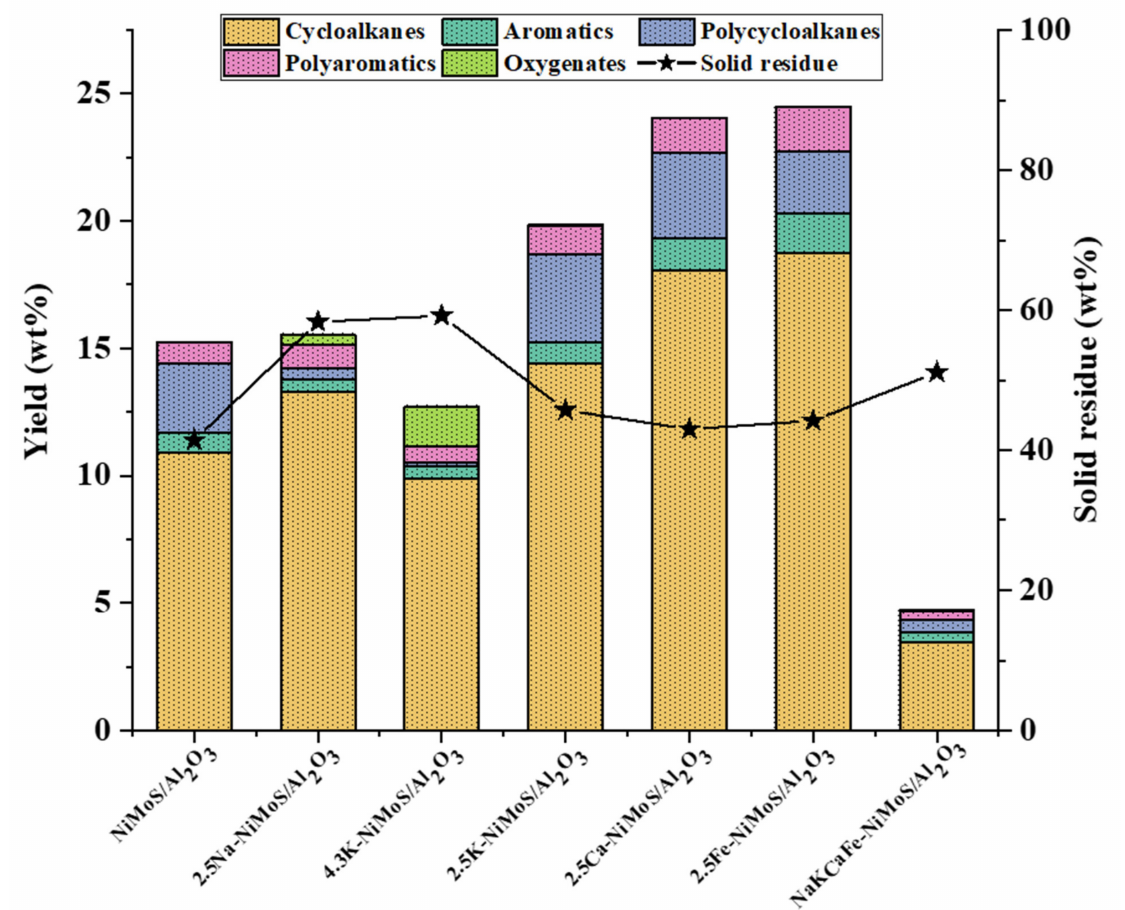
Figure 4. Comparison of activity of NiMoS/Al 2 O 3 catalysts containing different impurities. The solid residue generated over these catalysts were 45.7 wt%, 43.0 wt%, and 44.2 wt%, respectively, for K, Ca, and Fe, significantly lower than the 2.5 wt% of the Na- containing catalyst (58.3 wt%) (Figure 4), but only marginally higher than for NiMoS/Al 2 O 3 alone (41.1 wt%). Theoretically, the lignin amount that would deposit 2.5 wt% Na on the catalyst would result in only the deposition of 0.286 wt% of K, 0.052 wt% of Ca, and 0.0078 wt% of Fe on the catalyst (Table 1). The increase in the product yield and solid residue after the 3rd run of the catalyst was therefore due to the lower amount of deposition of impurities on it. The lower amount facilitated their promoting role on the